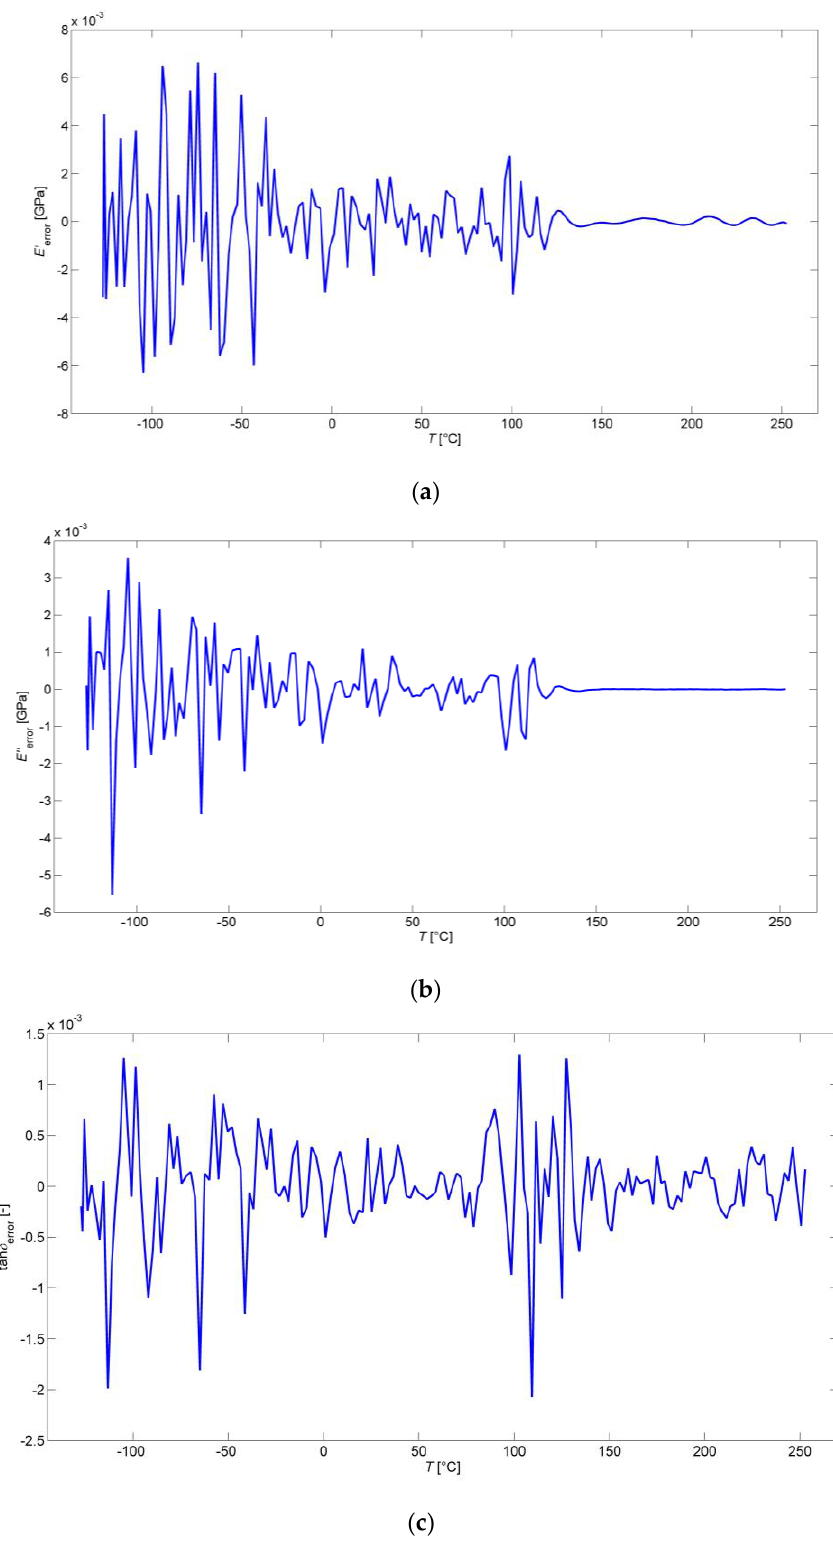
Figure 5. ( a ) Errors of the ANN model for E′ ( T ); ( b ) Errors of the ANN model for E′′ ( T ); and, ( c ) Errors of the ANN model for tan δ( T ).